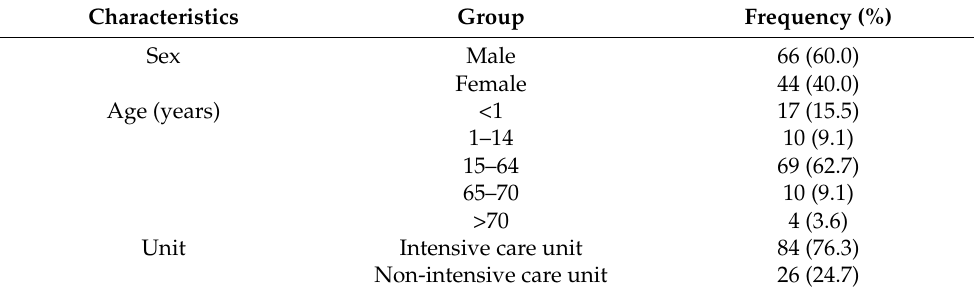
Table 1. Characteristics of the bacteremia patients with confirmed CNSAB ( n = 110).